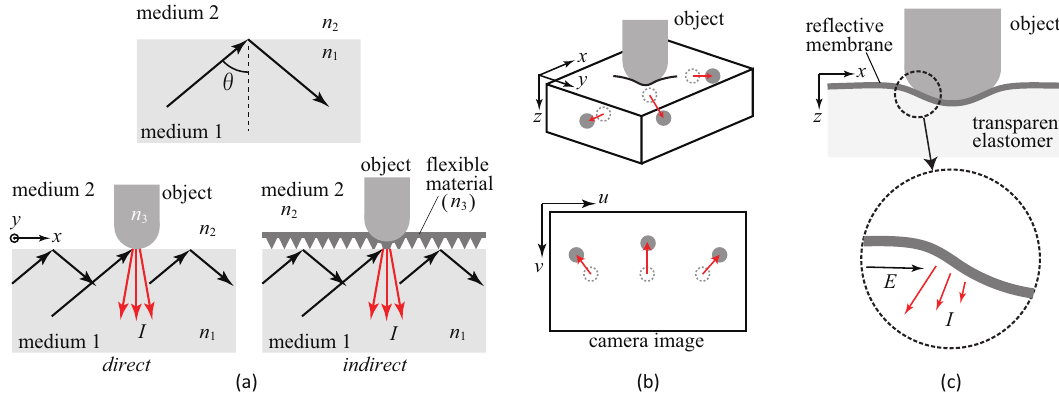
Figure 2. Principles of the three typical methods for converting physical tactile stimuli into light signals. ( a ) Light conductive plate-based method. The total reflection occurs if the incident angle θ is larger than the critical angle. When the object ( n 3 ) makes contact with the sensor (medium 1), the condition for total reflection is broken at this part, and the scattered light (shown by the red arrows) is observed (direct method). In the case of using a flexible cover, this cover makes contact with the sensor (indirect method). ( b ) Marker displacement-based method. The markers (shown by the gray circles) move from the initial position (dotted circles) according to deformation of elastomer. These movements can be observed as two-dimensional motion on the camera image. ( c ) Reflective membrane-based method. The deformation of the sensor surface, which is coated by the reflective membrane, causes a gradient change at each point on the surface. The intensity of the reflective light changes depending on the gradient